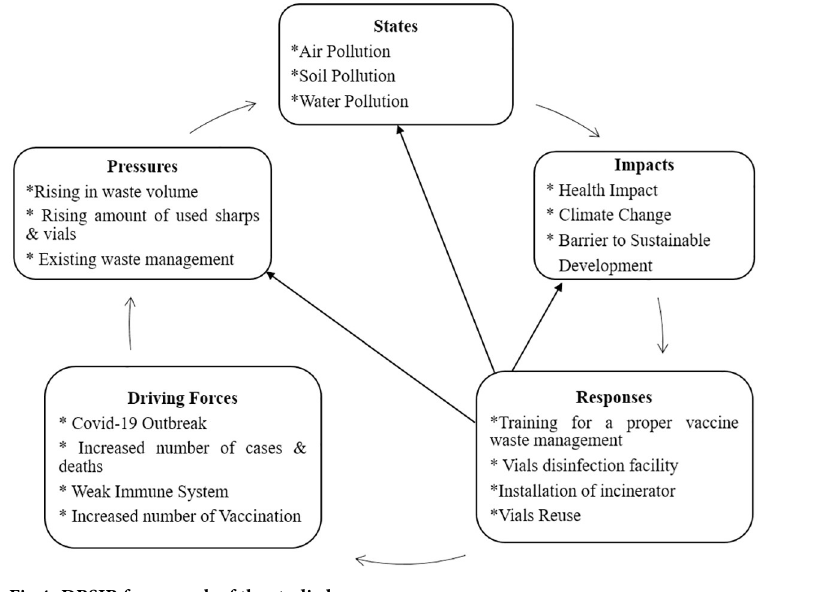
Fig 4. DPSIR framework of the studied